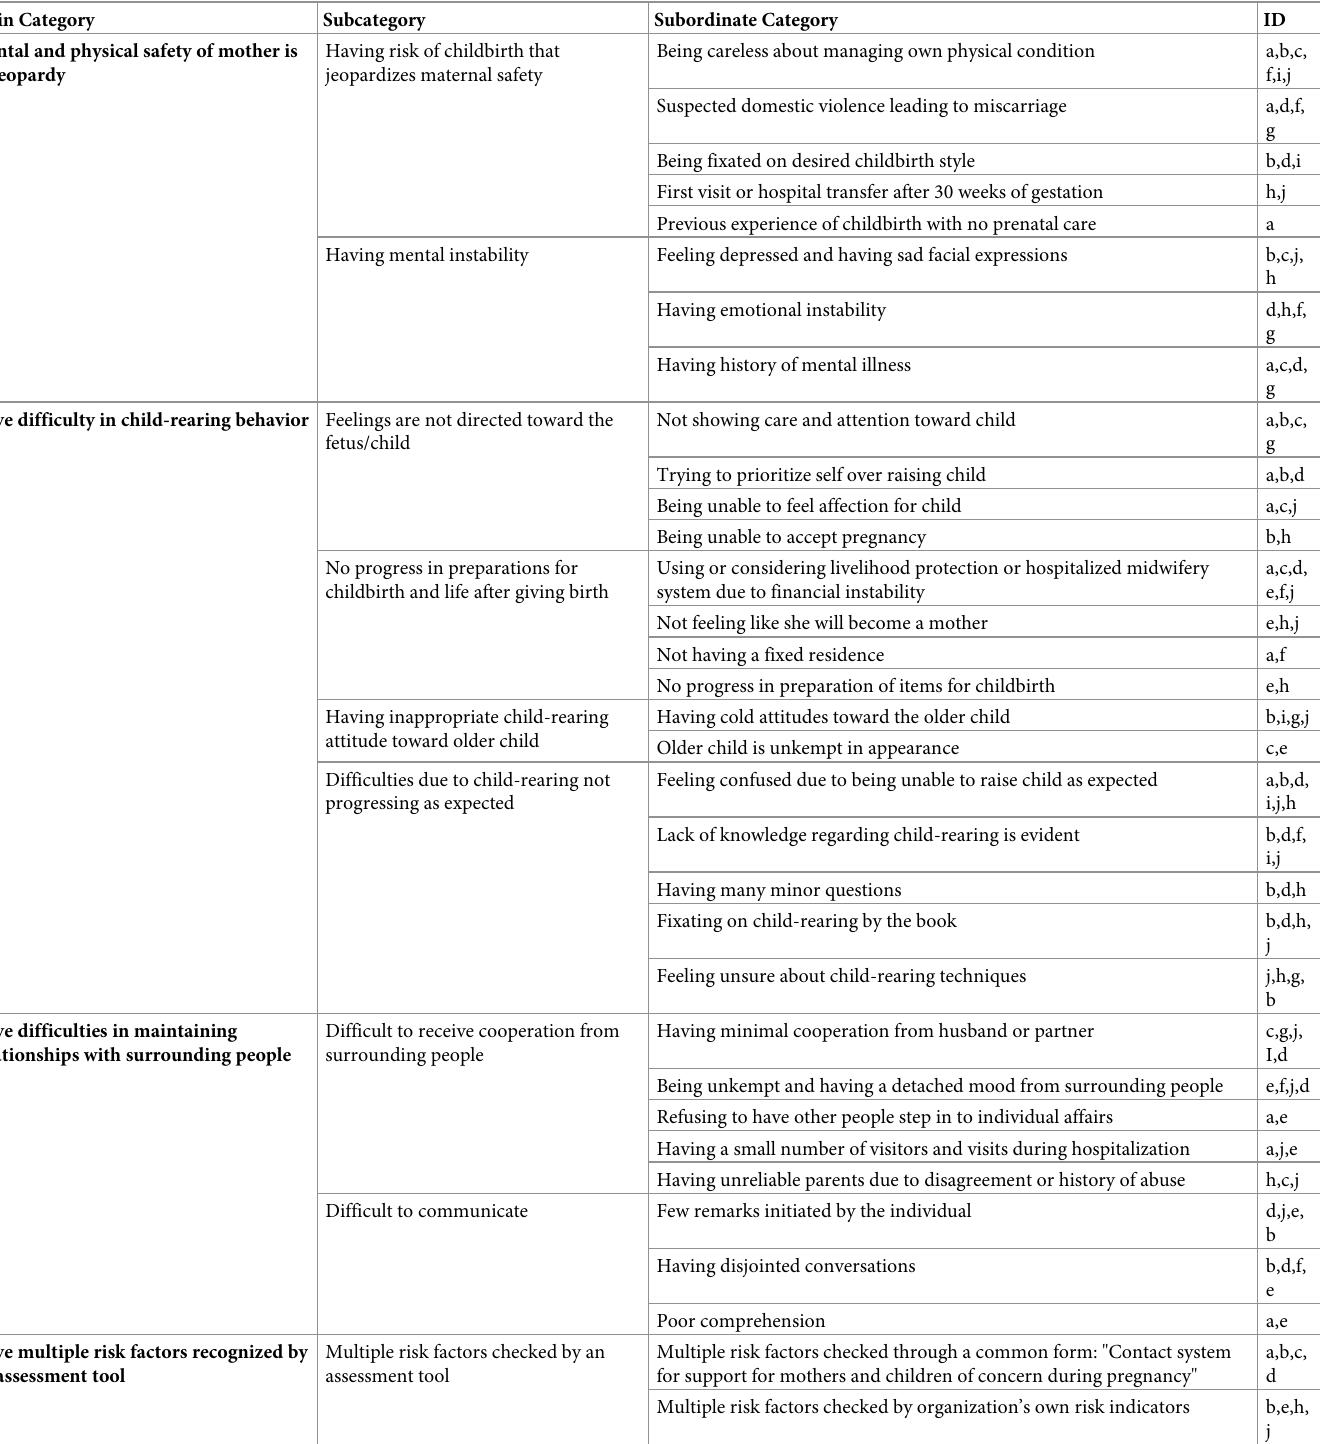
Table 3. Characteristics of pregnant and postpartum women of concern as seen by